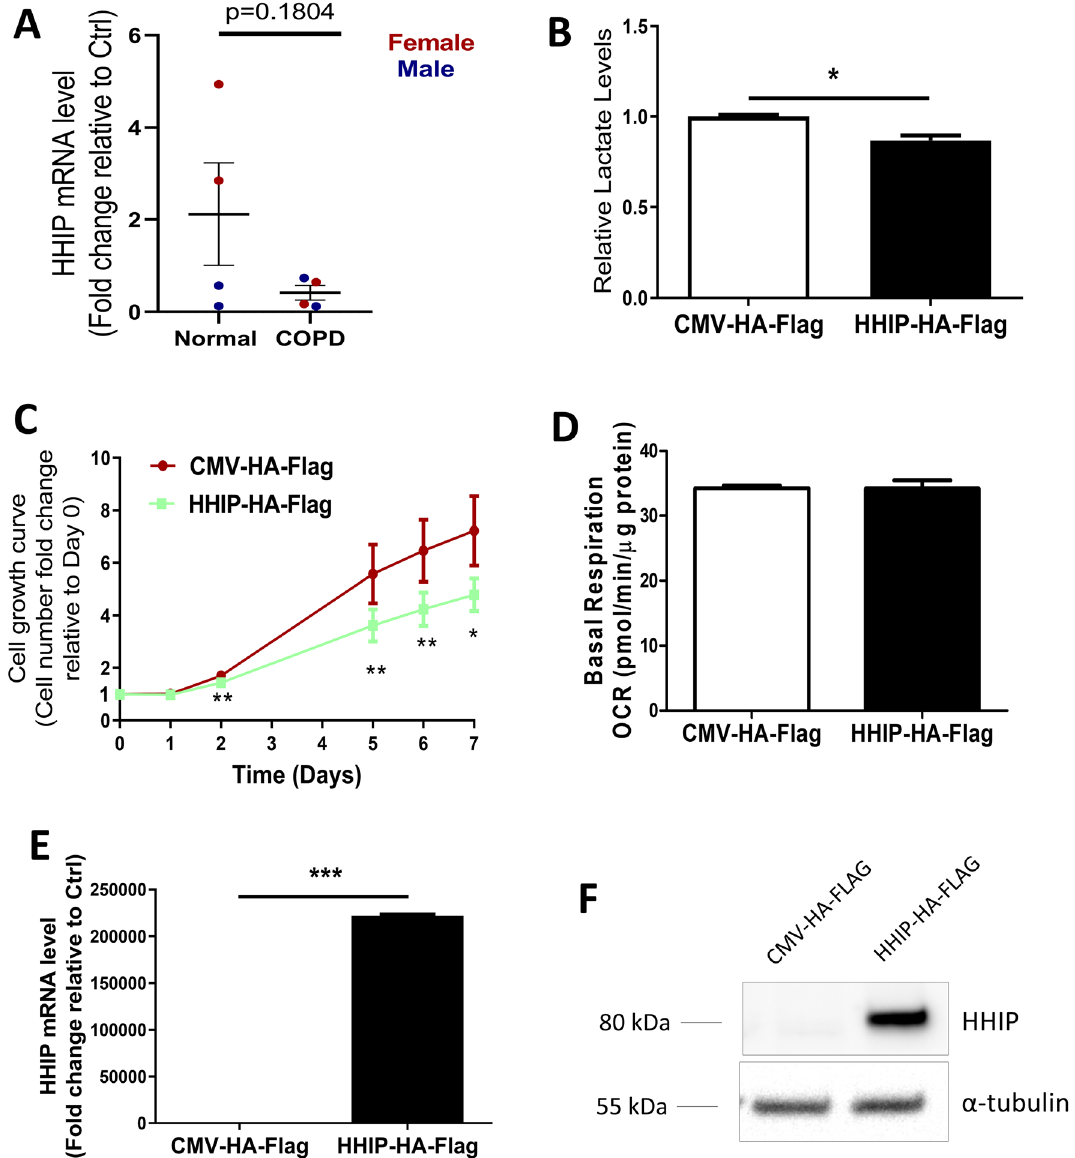
Figure 2. HHIP repressed proliferation and glycolytic metabolic reprogramming of COPD-derived ASMCs. ( A ) The HHIP mRNA levels were measured in ASMCs from healthy individuals (N = 4) and COPD patients (N = 4) by RT-qPCR. Red dots indicate data from female subjects, and blue dots indicate data from male subjects. ( B – F ) COPD-derived ASMCs were transfected with either HHIP overexpressing plasmid or empty vector, followed by measurements of ( B ) Lactate levels, ( C ) proliferation rates, ( D ) basal OCR, ( E ) HHIP mRNA levels, and ( F ) HHIP protein levels. * P < 0.05, ** P < 0.01 by unpaired t-test. Means ± SEM from 3–4 biological and technical repeats are shown for each